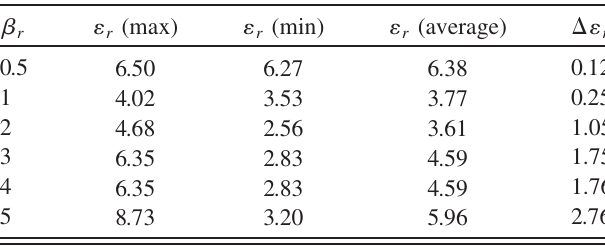
TABLE I. " r versus (cid:5) r , with L B ¼ 2 m and a varying from 1 to 50 m.